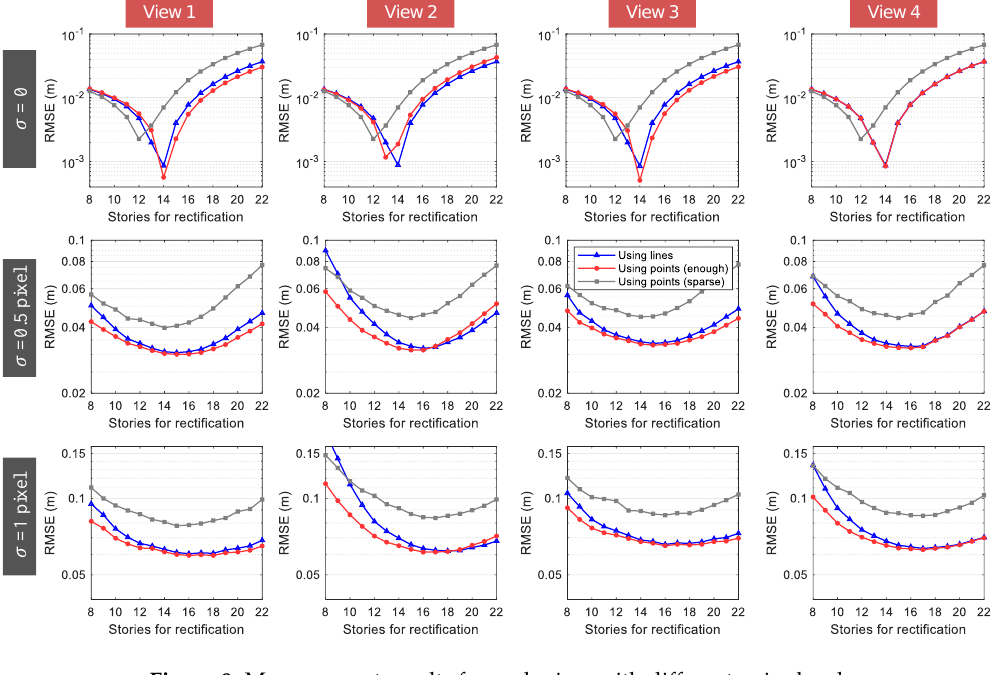
Figure 9. Measurement results for each view with different noise levels.